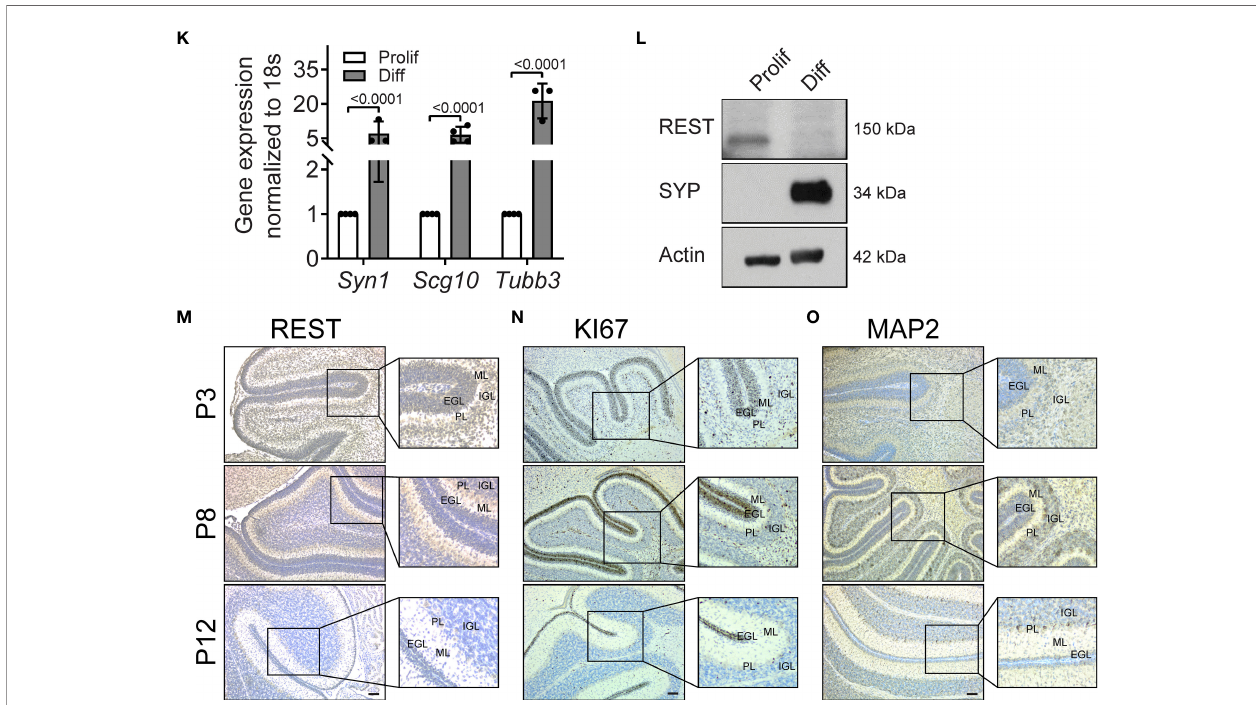
FIGURE 1 | REST expression is transcriptionally downregulated during neurogenesis of CGNPs. (A) Principal component analysis (PCA) was performed on the RNA-Seq data derived from proliferating (white dot) and differentiating (gray dot) CGNPs. Samples are plotted using the fi rst two principal components (PC). (B) Volcano plot to show fold change of gene expression between proliferating and differentiating CGNPs. The horizontal line on the y-axis indicates p-value at 0.05. (C, D) Top 5 enriched pathways for up-/down-regulated genes and for down-regulated genes, respectively. (E) Rest gene structure. (These includes not detectable Rest variants. It should be Rest- 201 and -202.) Rest- 201; ENSMUST00000080359.12. Rest- 202; ENSMUST00000113449.2. (F) Rest expression of proliferating (white bar) and differentiating (gray bar) CGNPs by RNA-Seq (FPKM). P values were calculated based on unpaired student ’ s t-test. (G) Expression of Rest isoforms -201 and -202 measured by RNA-Seq (FPKM) of proliferating (white bars) and differentiating (gray bars) CGNPs. P values were calculated based on unpaired student ’ s t-test. (H) Location of PCR amplicons in Rest locus. (I) Rest mRNA levels in proliferating (white bar) and differentiating (gray bar) CGNPs. Data are means +/- SD from 5 pups for each condition. (J) Primers speci fi c to TSS1 and TSS2 were used to distinguish the levels of isoforms Rest-201 and Rest-202 under proliferating (white bars) and differentiating (gray bars) conditions. Data shown is Rest expression relative to 18s. (K) Syn1, Scg10 and Tubb3 mRNA levels in proliferating (white bars) and differentiating (gray bars) CGNPs. Data are means +/- SD from 5 pups for each condition. (L) Western blot showing REST (proliferating) and Synaptophysin (SYP) (differentiating). Actin as a loading control is shown. Blot is representative from 2 western blots using n=5 mice for each condition. (M – O) Cerebellar sections from C57/Bl6 pups at P3, P8 and P12 were harvested, fi xed and sectioned. Abundance of REST (M) , KI67 (N) and MAP2 (O) was measured by IHCs using speci fi c antibodies. Scale bars, 20 um. EGL, external granule layer; IGL, internal granule layer; PL, Purkinje layer; ML, molecular